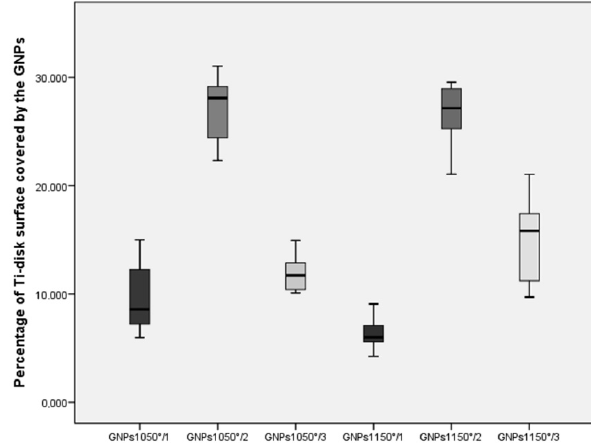
Figure 3. FE-SEM images of Ti-disk surfaces coated by the six different types of GNPs: ( a ) untreated Ti-disk surface ( b ) GNPs 1050°/1 , ( c ) GNPs 1050/2 , ( d ) GNPs 1050°/3 , ( e ) GNPs 1150°/1, ( f ) GNPs 1150°/2 , and ( g ) GNPs 1150°/3 .